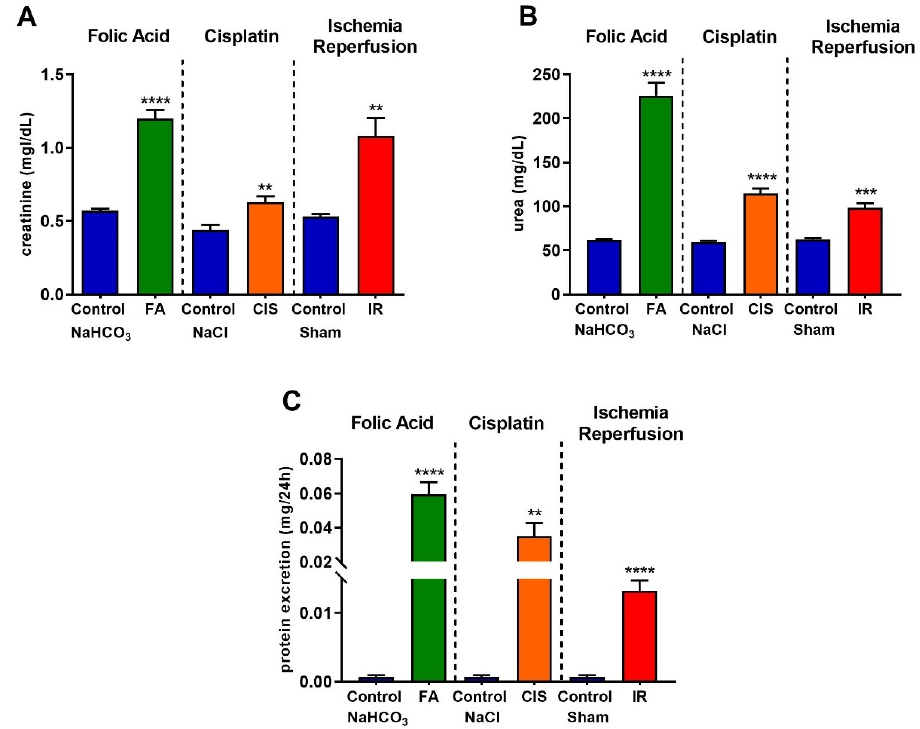
Figure 1. Renal function in different models of chronic kidney disease. Renal function was determined by serum creatinine ( A ), urea ( B ), and protein excretion ( C ) after folic acid (FA) treatment, cisplatin (CIS) treatment, and ischemia reperfusion (IR) surgery. Data presented as mean ± SEM; n = 6–8. Two-tailed Student ´ s t-test. ** p < 0.01; *** p < 0.001; **** p < 0.0001.